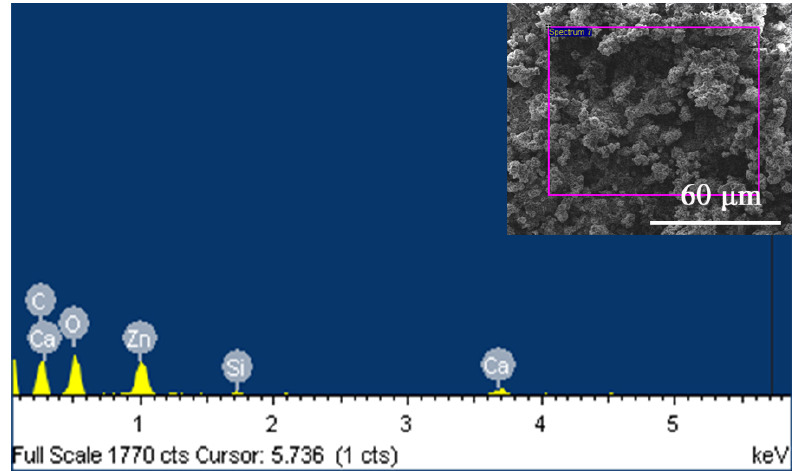
Figure 8. EDS diagram of superhydrophobic samples.